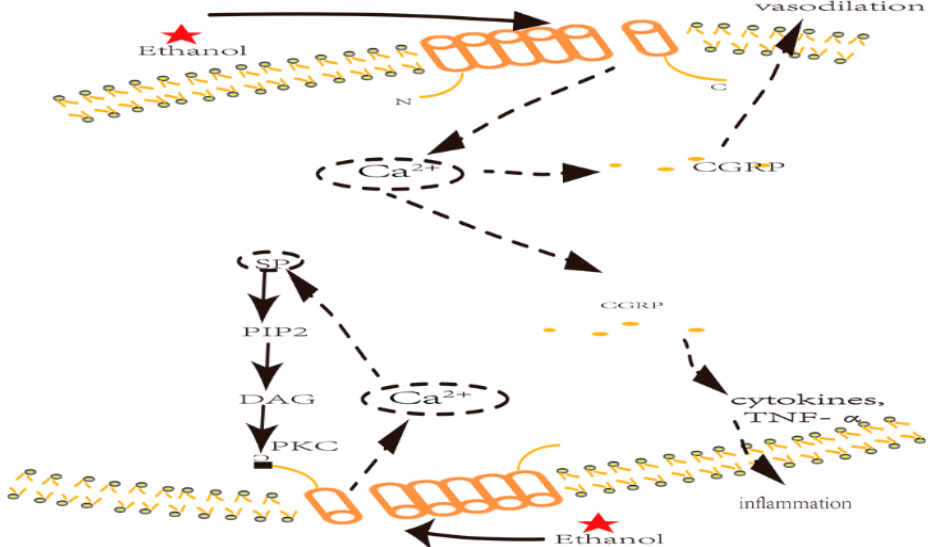
Figure 3. TRPV1 inflammation nociceptor activation and ethanol ‐ induced neuroinflammation. Key: CGRP: calcitonin gene ‐ related peptide; PKC: protein kinase C; NGF: nerve growth factor; LDCV: large dense ‐ core vesicle; SP: substance P; PIP2: phosphatidylinositol biphosphate; DAG: diacylglyc ‐ erol. Table 2. Research on the effects of ethanol and its derivatives in vitro .